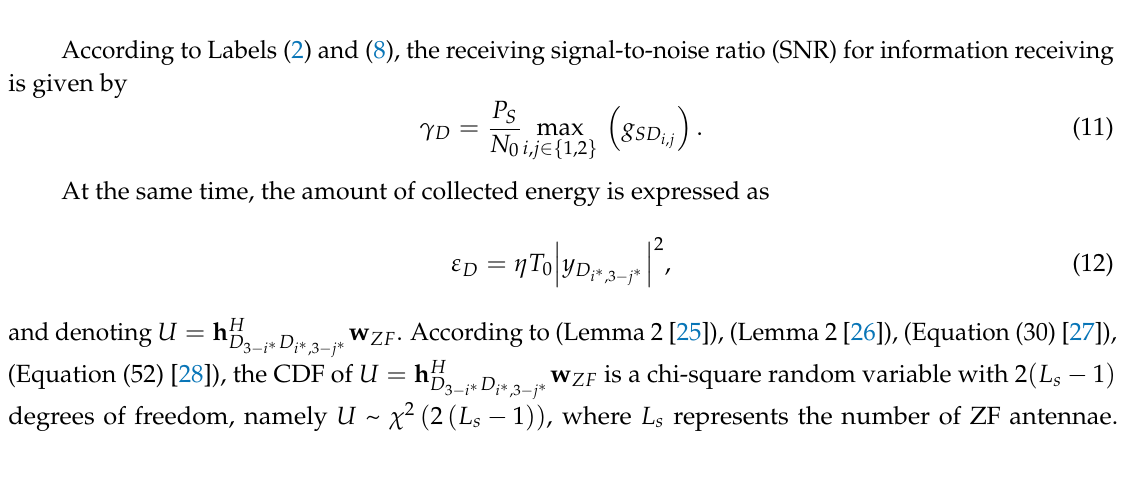
Figure 2. Time slot structure for user/antenna